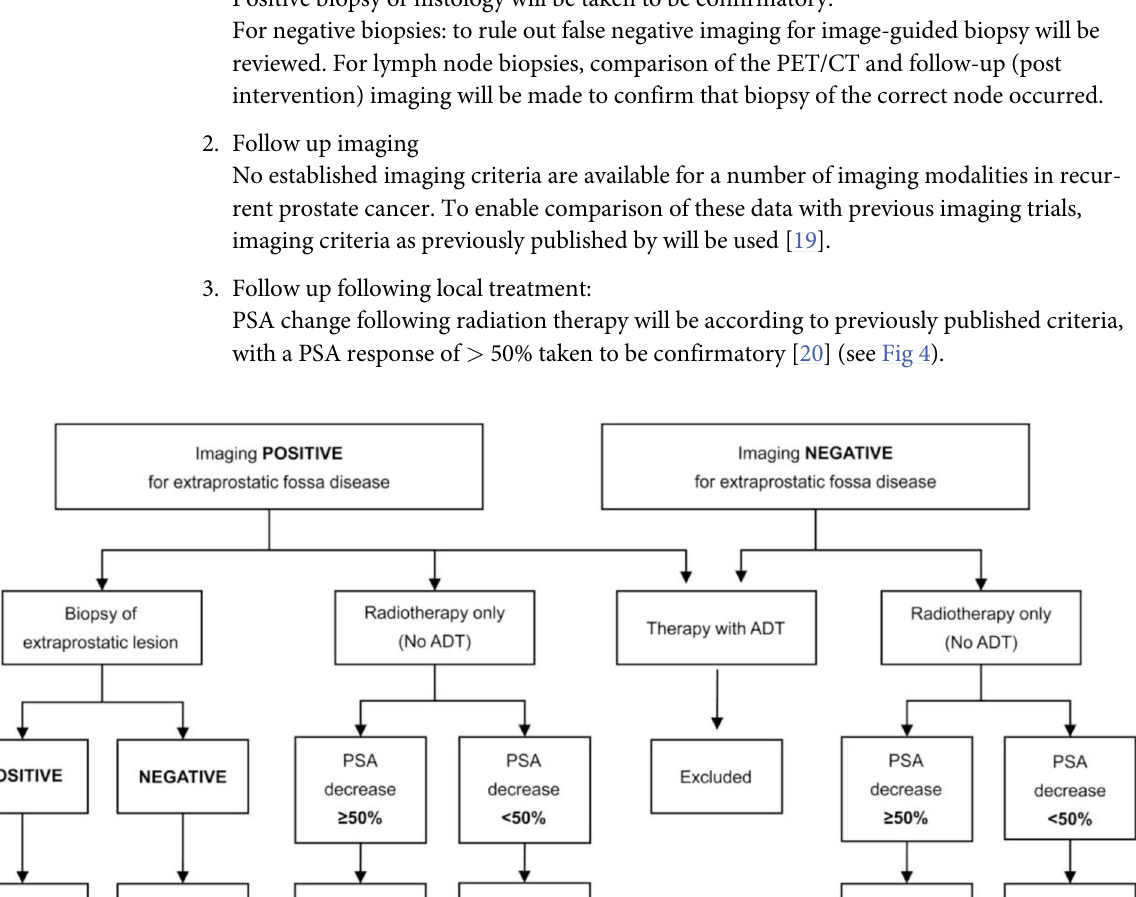
PLOS ONE | https://doi.org/10.1371/journal.pone.0270269 July 19,